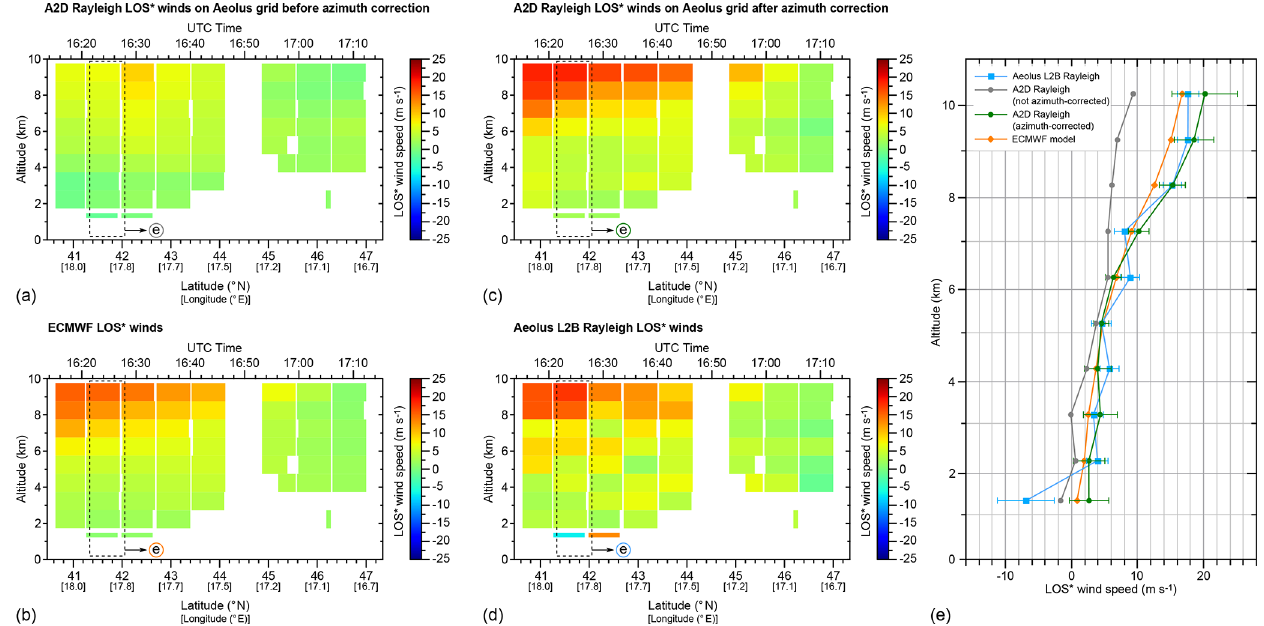
Figure 9. LOS* wind profiles obtained during the underflight on 22 November 2018 between 40.5 and 47.2 ◦ N: (a) A2D Rayleigh winds averaged onto the Aeolus measurement grid for an off-nadir angle of 37 ◦ without azimuth correction, (b) ECMWF model winds, (c) A2D Rayleigh winds with azimuth correction and (d) Aeolus L2B Rayleigh winds. White areas represent missing or invalid data for one of the two instruments, e.g. below dense clouds. Only Aeolus Rayleigh LOS* winds with an estimated error below 4.8ms − 1 were considered valid. The wind profile for one selected Aeolus observation is shown in panel (e) along with the corresponding profiles of the other three data sets. The error bar for the Aeolus winds (blue squares) represents the estimated error included in the L2B product, whereas the error bar for the azimuth-corrected A2D winds (green dots) corresponds to the weighted standard deviation of all A2D bins contributing to the respective Aeolus bin. For the uncorrected A2D winds (grey dots), the error bars were omitted for the sake of